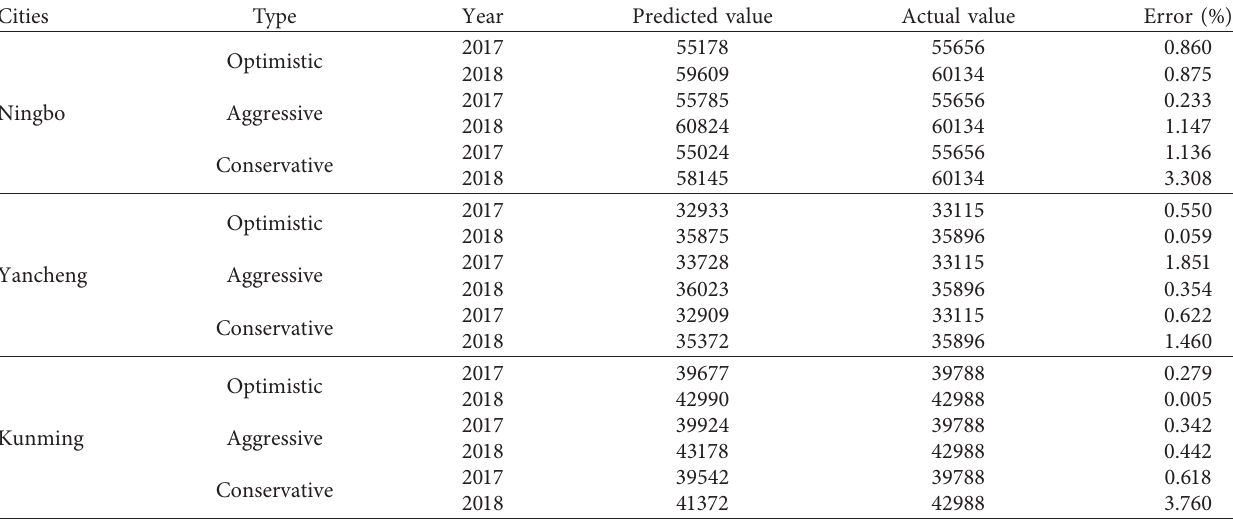
Table 12: Comparison of the predicted and actual PCDI values (unit (yuan)). Cities